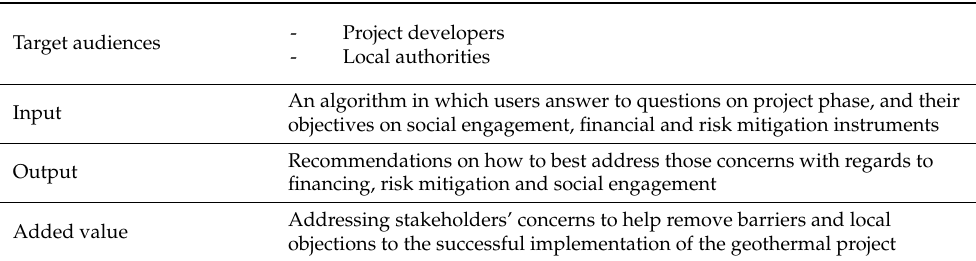
Table 5. Online Decision